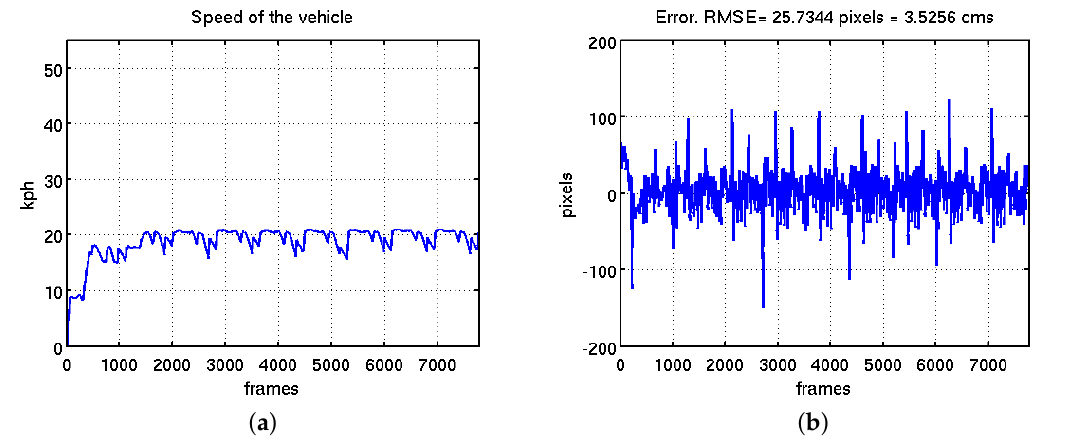
Figure 21. Finest adjustment of the steering wheel control system. ( a ) Vehicle speed evolution; ( b ) evolution of the error in pixels with a RMSE equal to 3.52